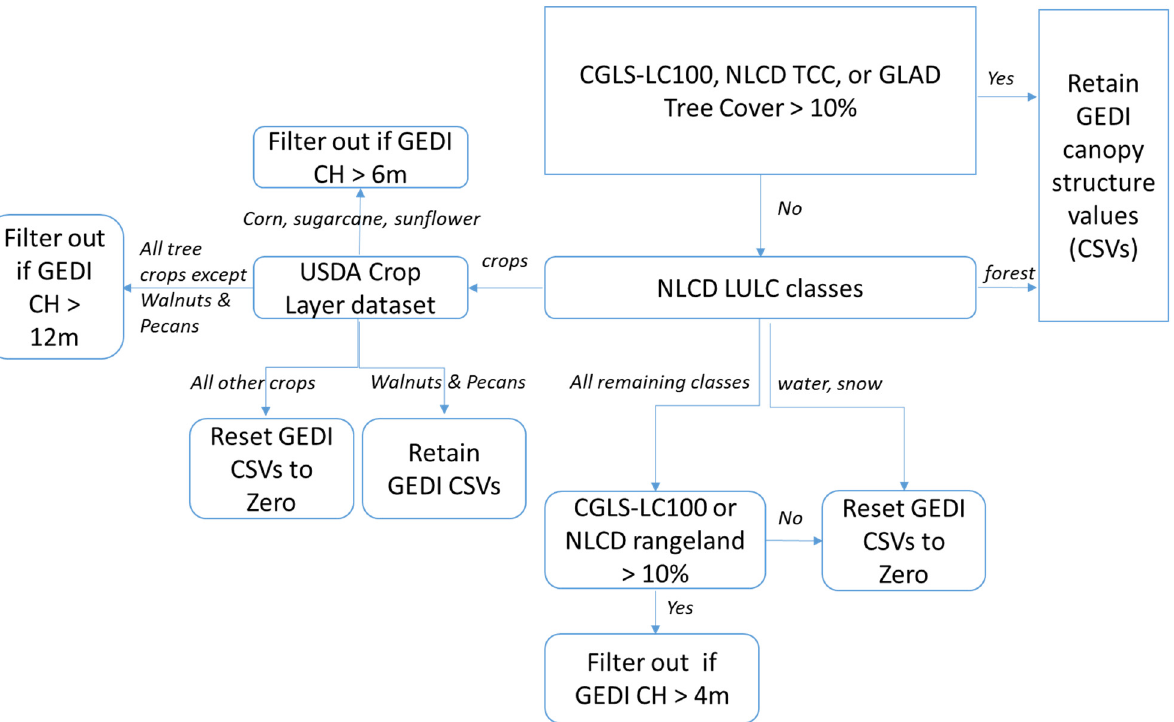
Figure 2. Flowchart showing the steps used in selecting, editing, and filtering the GEDI-derived Level 02B products.